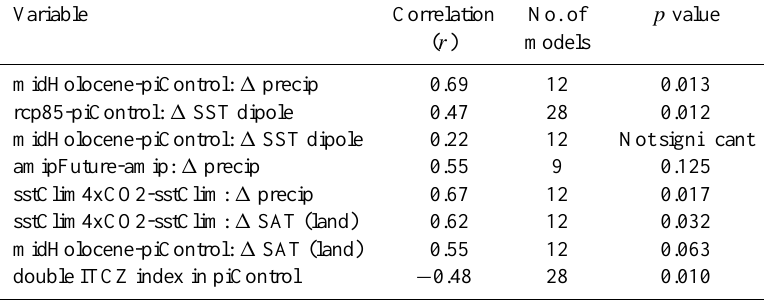
Table 2. Correlation of different variables with future precipitation change in the RCP 8.5 scenario. Precipitation changes are defined as in Fig. 3: annual-mean precipitation averaged over 0–8 ◦ N; 60–50 ◦ W minus annual-mean precipitation averaged over 5–15 ◦ S; 45–35 ◦ W; SST dipole changes are defined as the annual-mean change in SST averaged over 3–15 ◦ N; 50–20 ◦ W minus the annual-mean change in SST averaged over 3–15 ◦ S; 20–30 ◦ W (see boxes on Fig. 3b). Land surface warming is the annual-mean warming averaged over 0–15 ◦ S; 50–70 ◦ W. The double ITCZ index is defined as the annual-mean precipitation averaged over the southern branch (3–7 ◦ S; 20–35 ◦ W) minus the annual-mean precipitation averaged over the northern branch (3–7 ◦ N; 20–35 ◦ W). Variable Correlation No. of p value ( r )